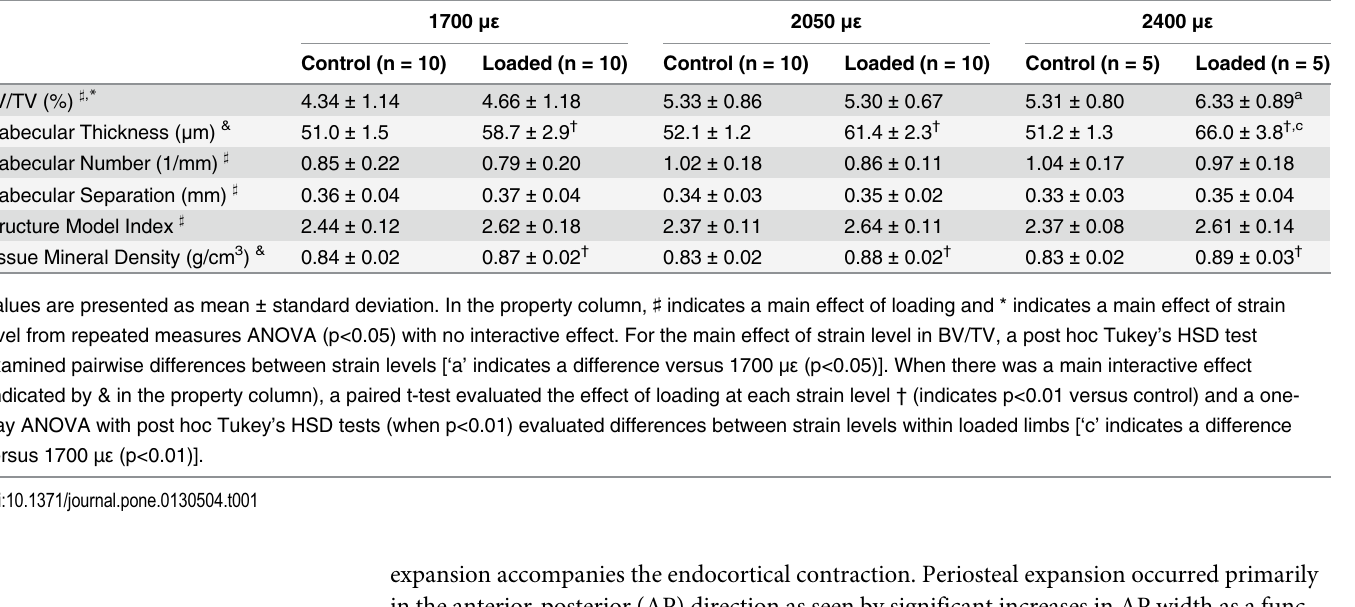
Table 1. Cancellous Architecture in the Proximal Metaphysis.